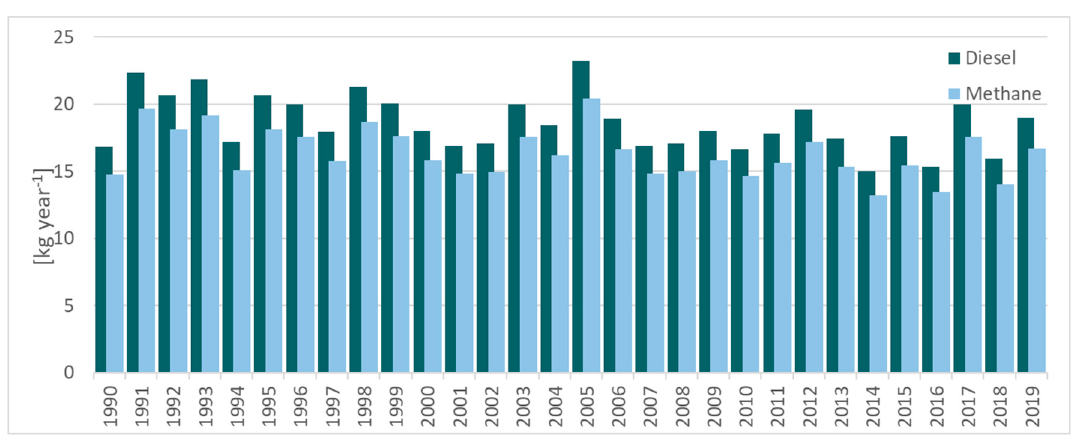
Figure 4. Diesel fuel and methane consumption for heating a greenhouse with rose cultivation. Data are expressed per year.